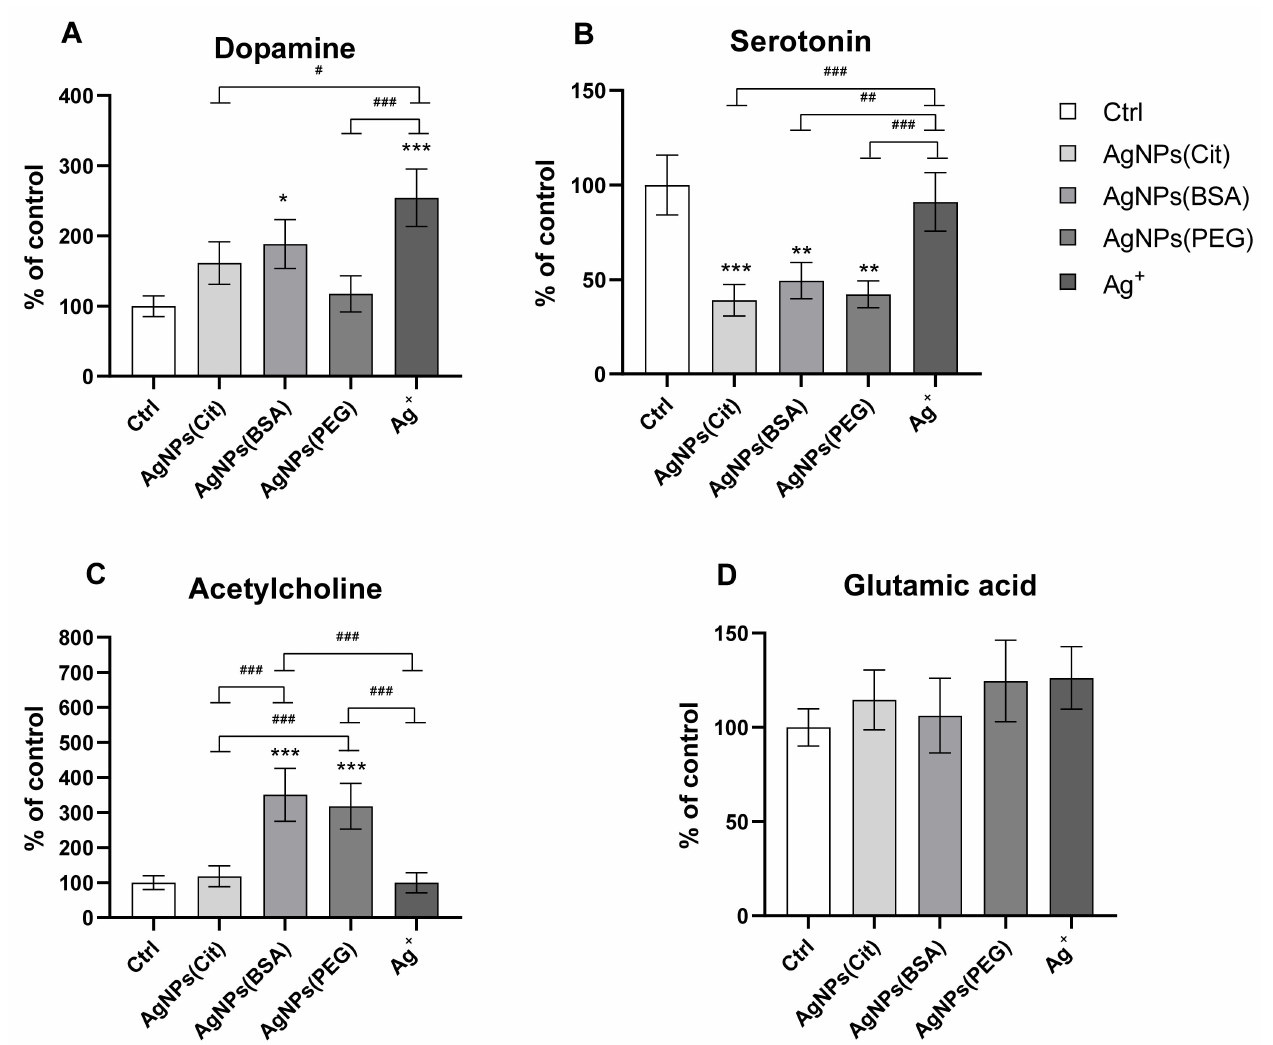
Figure 4. Levels of neurotransmitters in the hippocampus of rats exposed to AgNPs with different types of coating (citrate, BSA, and PEG) or Ag + . ( A )—dopamine (one-way ANOVA: F 4,23 = 10.98, p = 0.001); ( B )—serotonin (one-way ANOVA: F 4,23 = 15.06, p = 0.001); ( C )—acetylcholine (one-way ANOVA: F 4,24 = 28.37, p = 0.001); ( D )—glutamic acid (one-way ANOVA: F 4,24 = 0.67, NS) (% of Ctrl ± SEM). *, **, and ***: Significantly different from the Ctrl group (* p < 0.05, ** p < 0.001, and *** p < 0.001) (Tukey post hoc test). # , ## , and ### : Significant differences between the groups exposed to AgNPs or Ag + ( # p < 0.05, ## p < 0.001, and ### p < 0.001) (Tukey post hoc